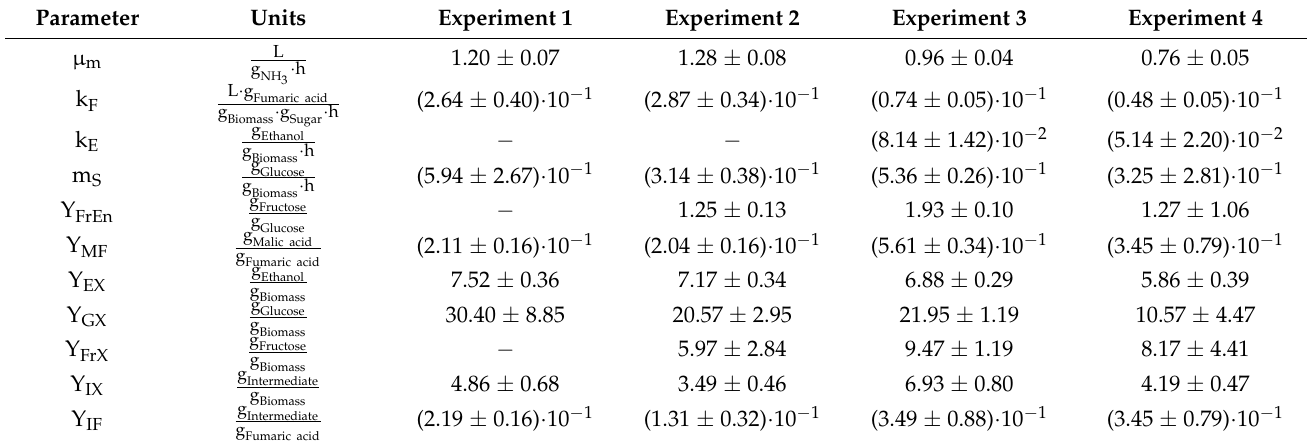
Table 4. Kinetic parameters for the proposed kinetic model obtained by statistical fitting.